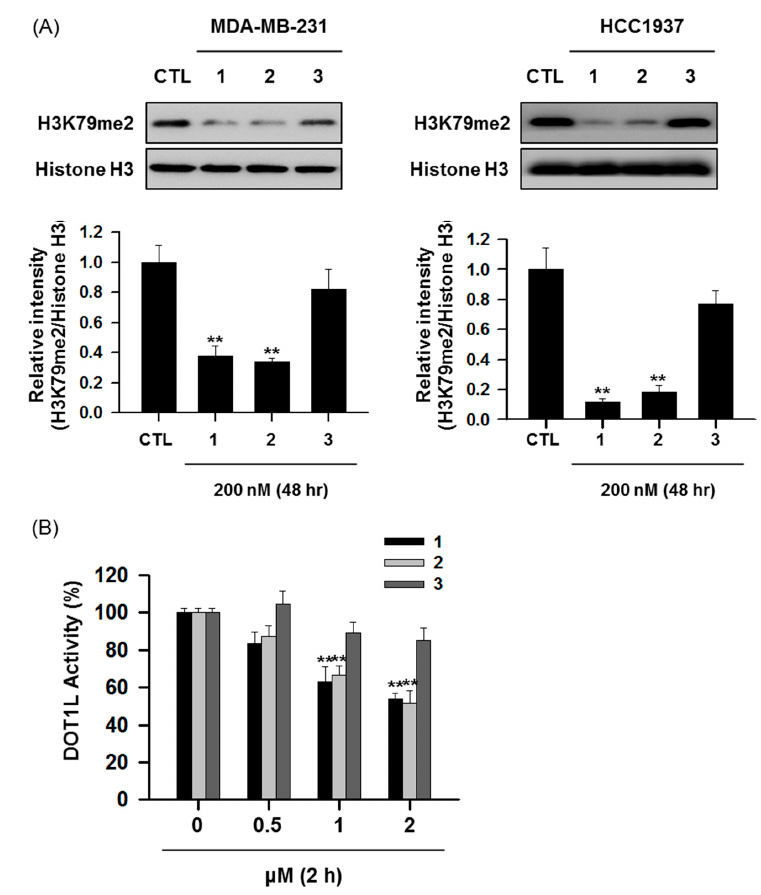
Figure 2. Suppressive effects of NepA analogs on H3K79me2 via the inhibition of DOT1L. ( A ) MDA-MB-231 and HCC1937 cells were treated with NepA analogs (200 nM) for 48 h, and H3K79me2 levels were determined by Western blotting. Histone H3 was used as an internal control. The relative intensities of the indicated protein levels were analyzed semi-quantitatively using NIH ImageJ software. ( B ) DOT1L (500 ng / well) enzyme activity levels were analyzed after incubation with NepA analogs (0.5–2 µ M) for 2 h. All data are expressed as mean values ± SD (n = 3) and are representative of three separate experiments. ** p < 0.01 indicates significant di ff erences relative to the vehicle-treated control